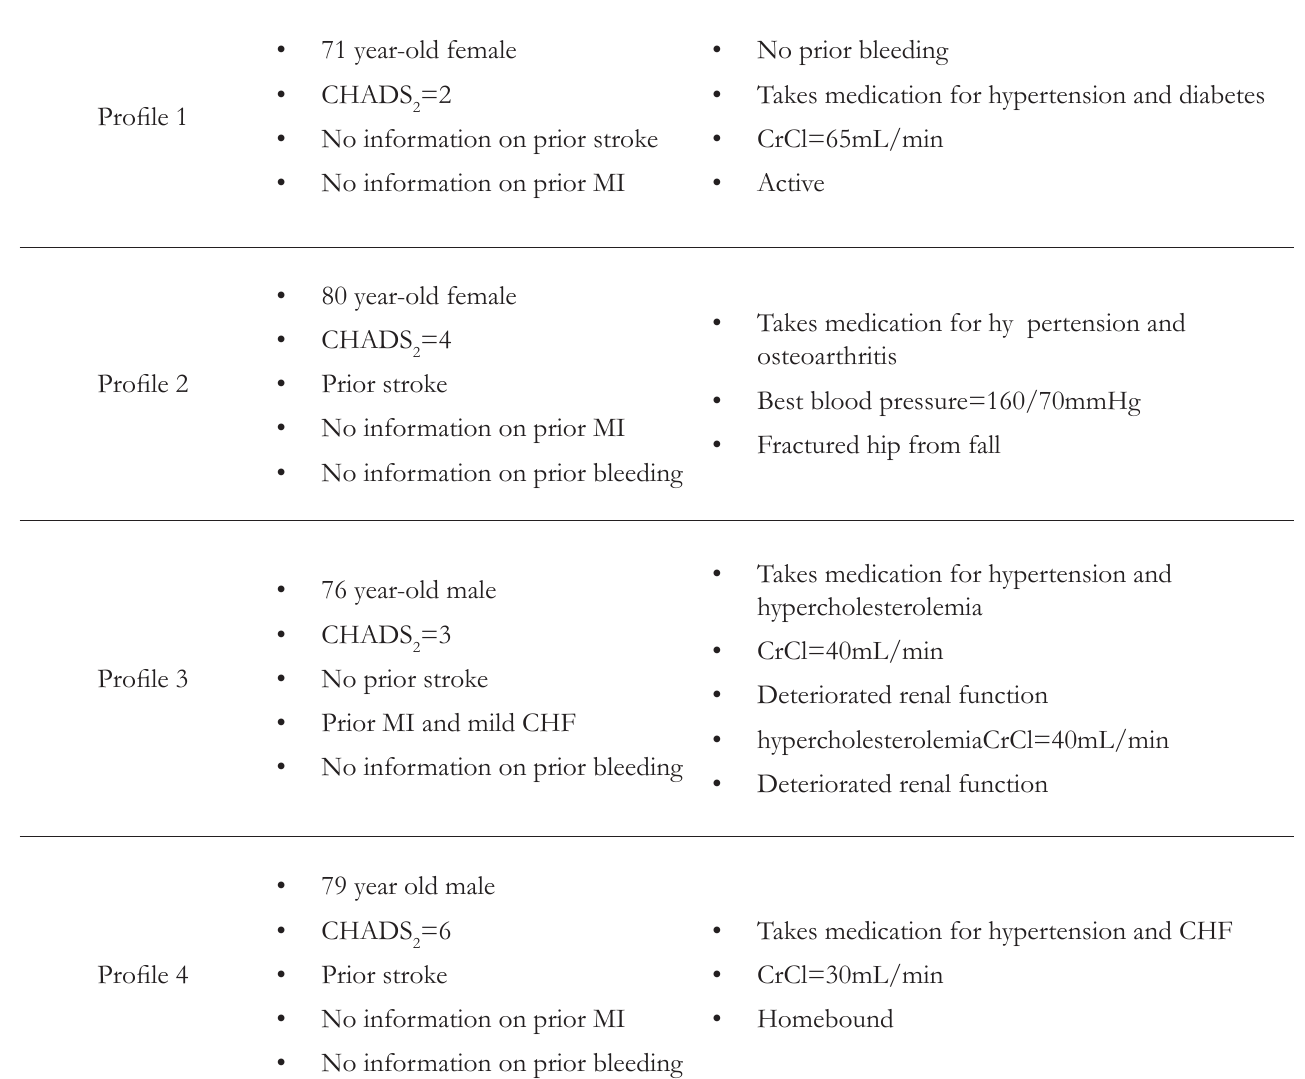
Profile Number Key